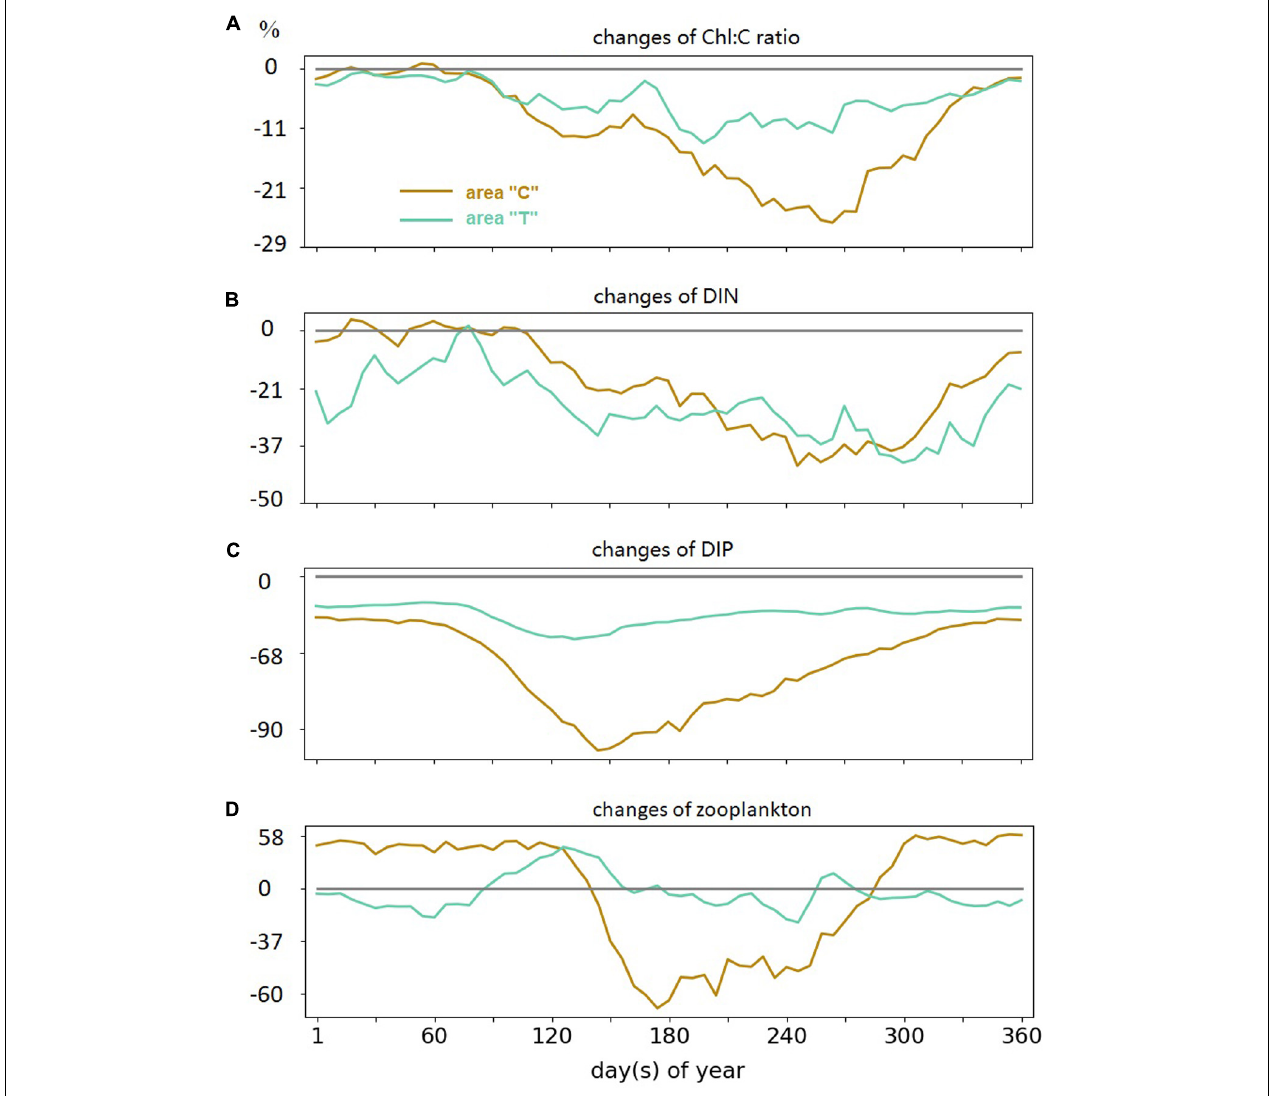
FIGURE 8 | Simulated 6-day variations differences between two periods (1987–2012 – 1961–1982) in panel (A) Chl:C ratio, (B) DIN concentration, (C) DIP concentration, and (D) zooplankton; all in areas “C” and “T” in log-10